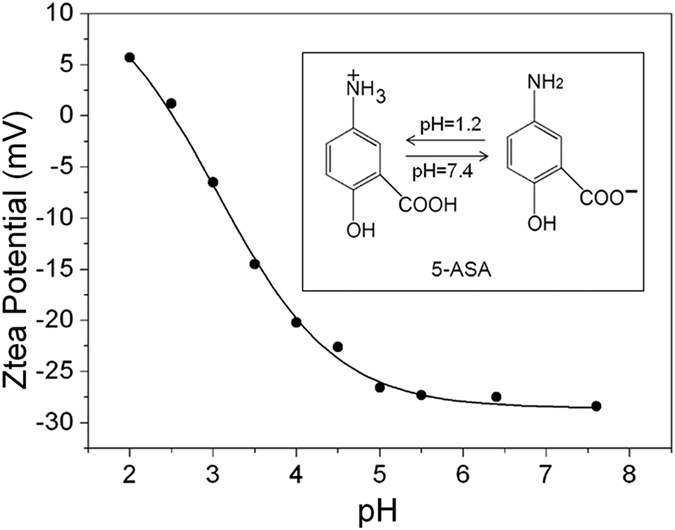
The ζ-potential of UCNPs@SiO2@PMAA and (inset) ionized 5-ASA molecular at different pH values.